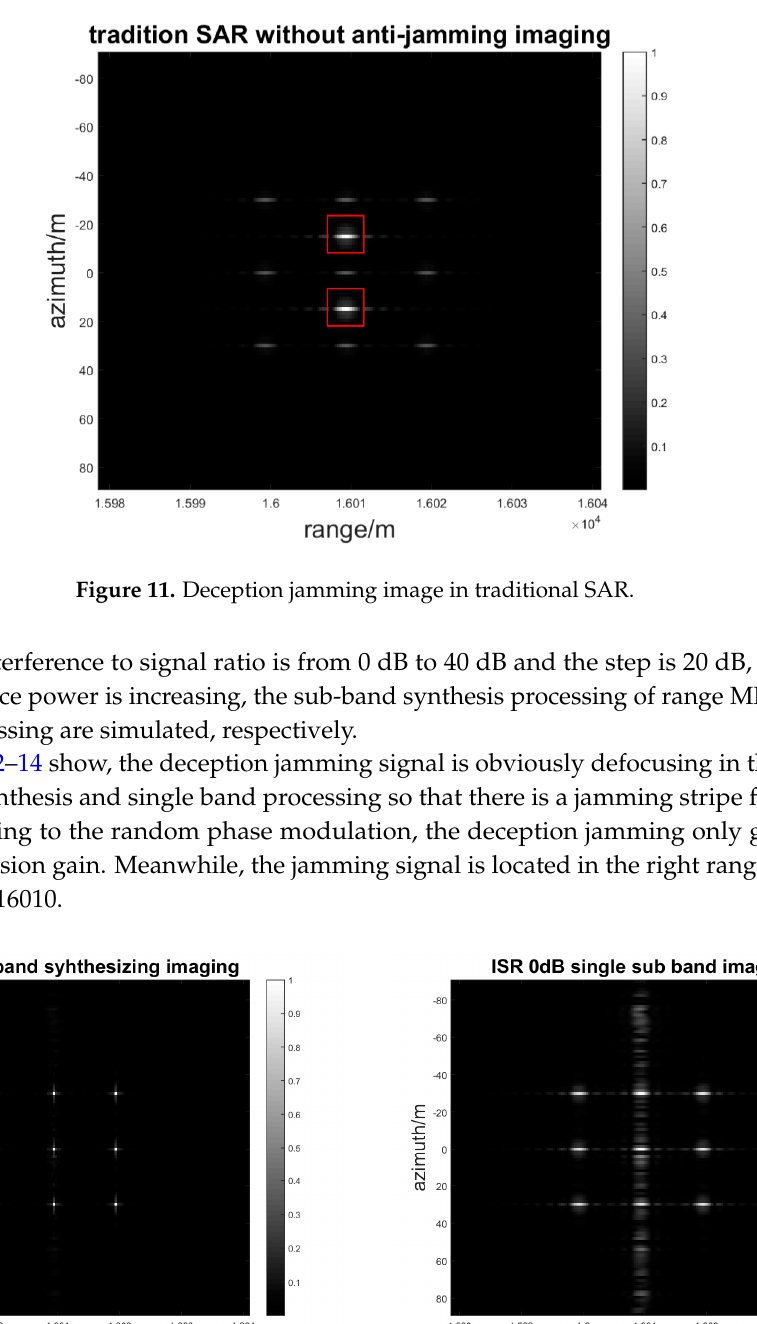
Figure 11. Deception jamming image in traditional SAR.